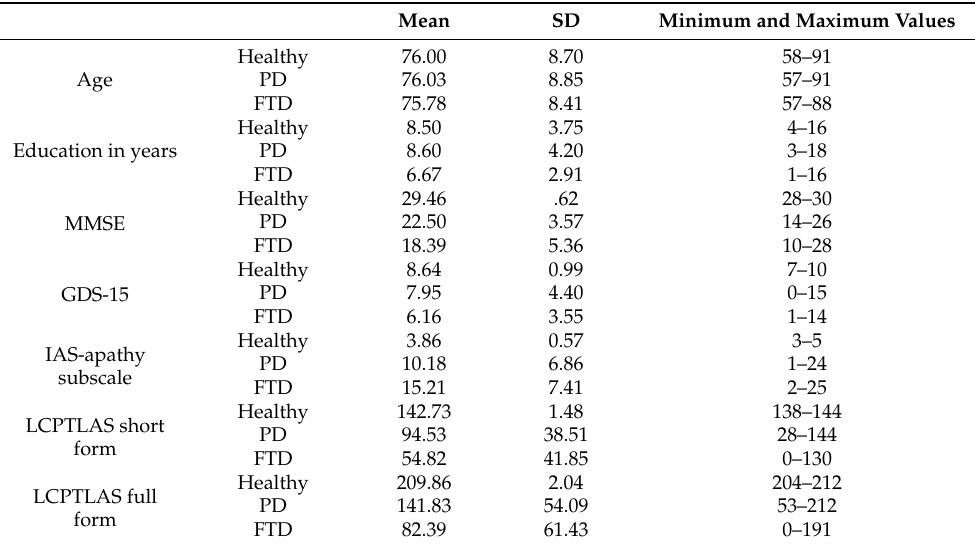
Table 1. Demographics and scores on MMSE, LCPTLAS full and short form, IAS, and GDS-15, of PDD patients, FTD patients and healthy